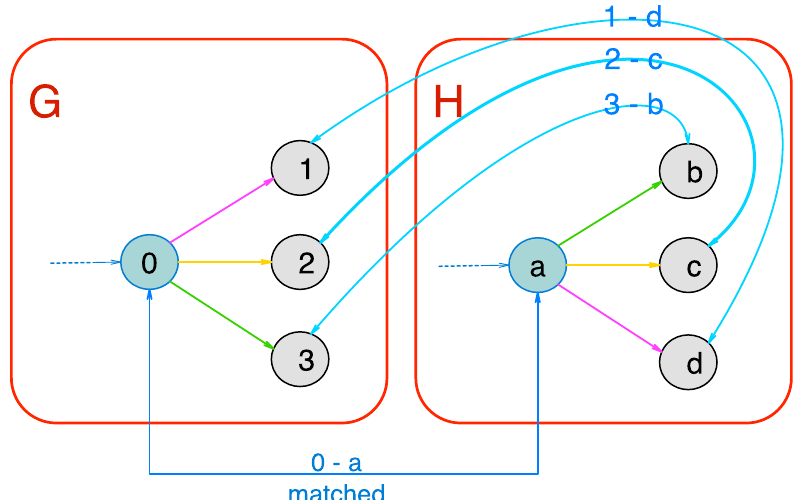
Fig 3. Impact of proper edge-coloring on graph-matching. This figure displays a piece of two graphs (G on the left and H on the right) in which the nodes 0 and a are already matched together. The next step is to match their neighbours. In the generic case, all permutations have to be tested. On the contrary, in the example displayed, the colors of the edges limit the options to consider to a single